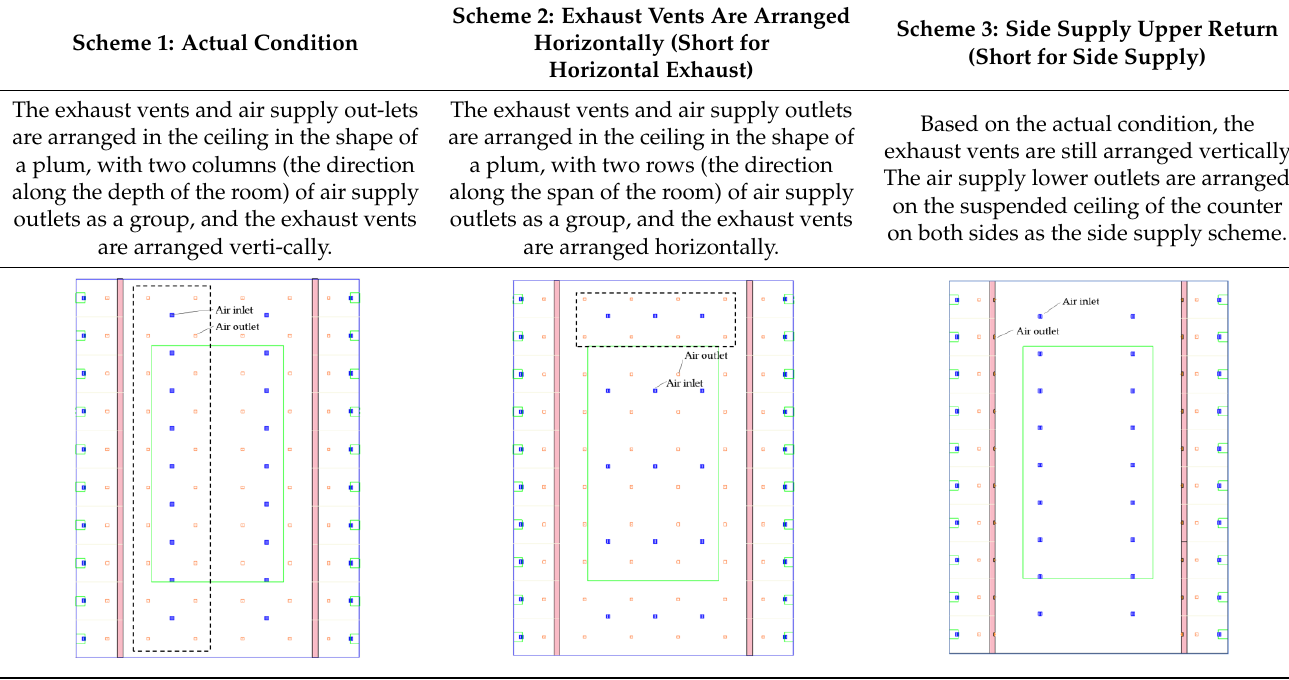
Table 2. Different scheme